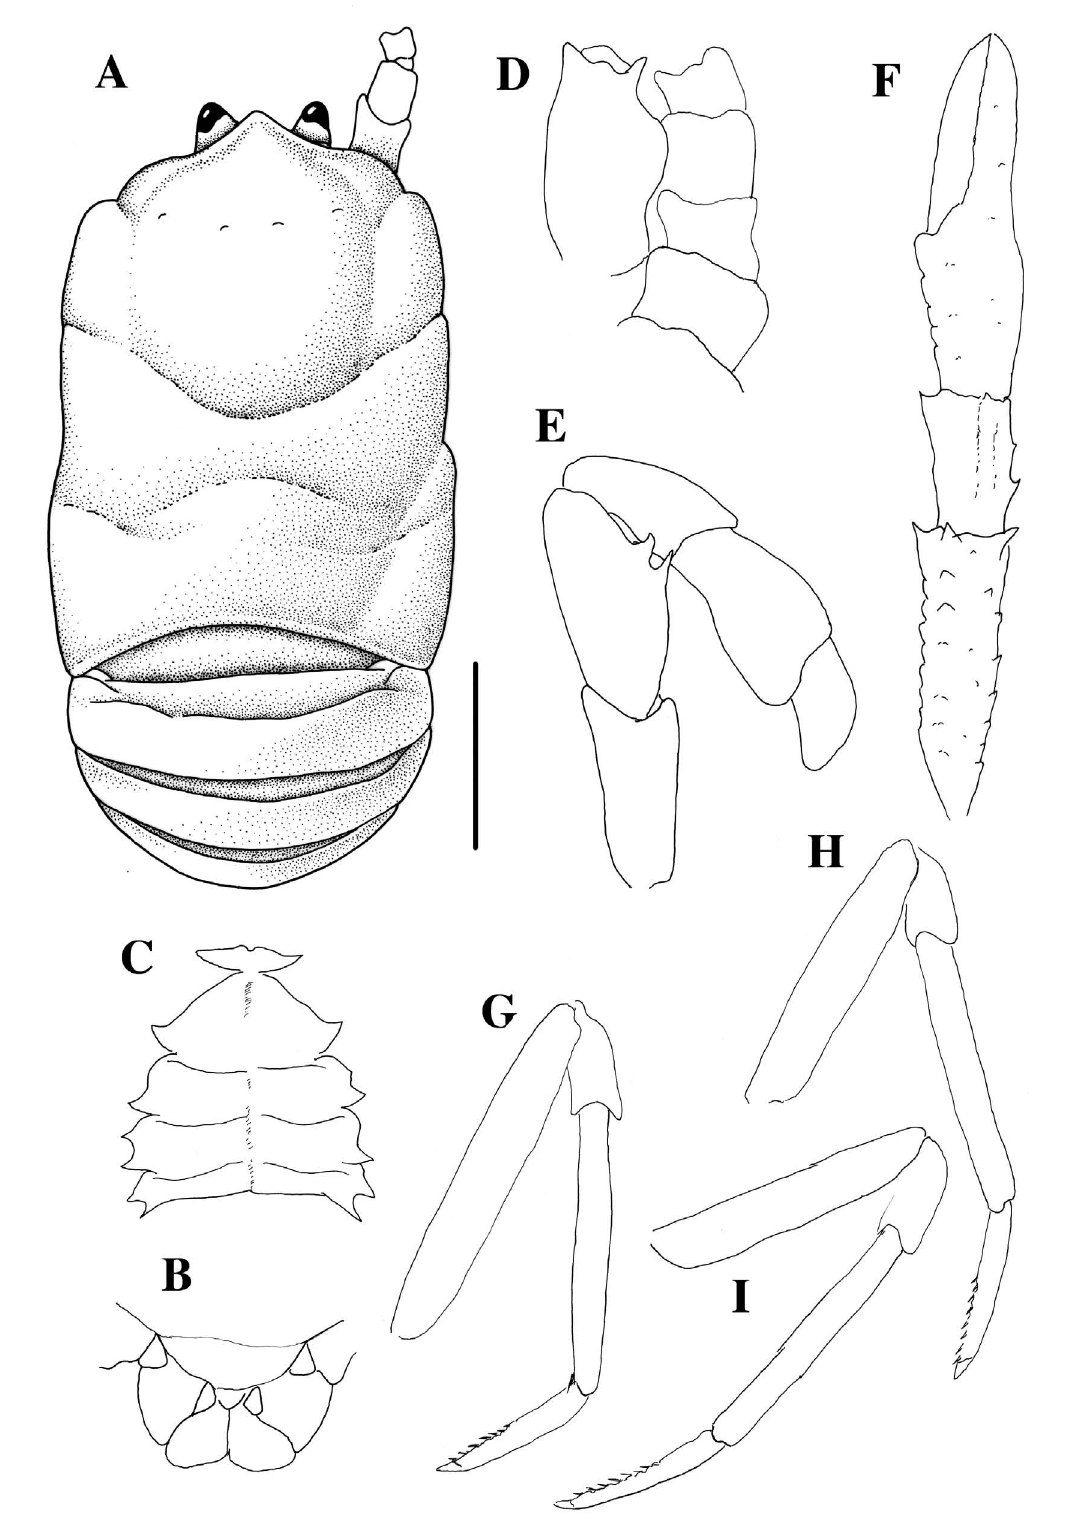
Fig . 3. – Munidopsis polymorpha Koelbel, 1892, male 6.1 mm (ICM). A, carapace and abdomen, dorsal view. B, telson. C, sternal plastron. D, left antenna and antennula, ventral view. E, right maxilliped 3. F, right P1. G, Right P2. H, Right P3. I, Right P4. Scale: A-C, F-I, 2.0 mm; D-E, 1.0